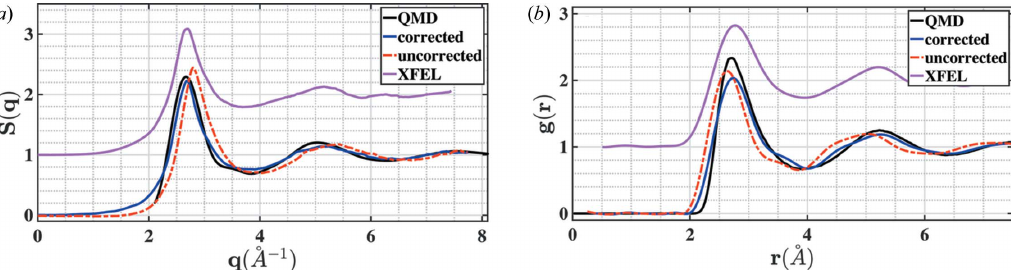
Figure 5 ( a ) Structure factor and ( b ) radial distribution function from shock melted tin for measurements at LCLS-II, DCS (corrected and uncorrected) as well as the QMD simulations. While a direct comparison is not possible (see text), the proposed algorithm leads to reasonable results for liquid tin of comparable pressures and